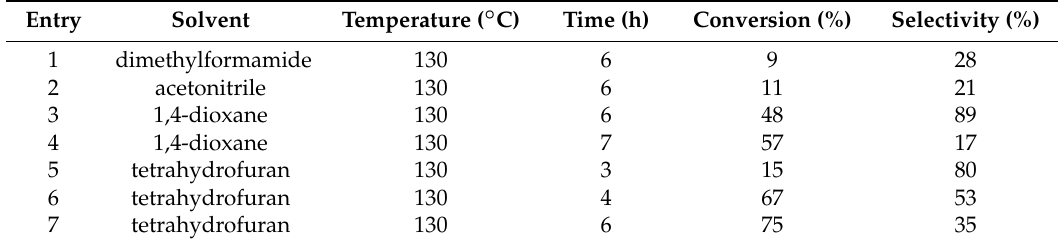
Table 2. Catalytic performance of the Ba(II) complex in the oxidation of benzyl